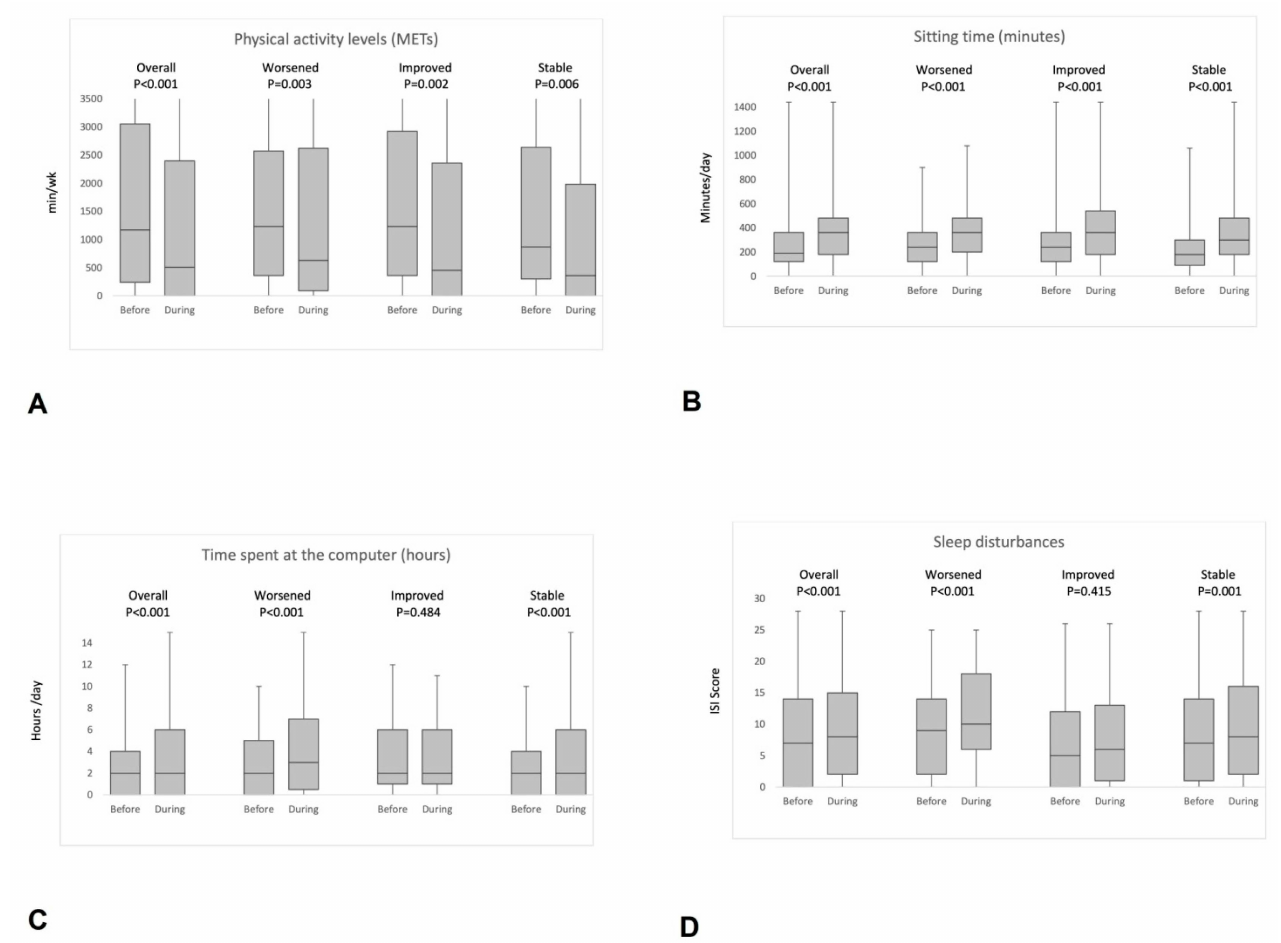
Figure 1. Box plots of changes in median metabolic equivalent task (METs) ( A ), sitting time ( B ), computer time ( C ), and median Insomnia Severity Index (ISI) ( D ) according to migraine frequency variation during social